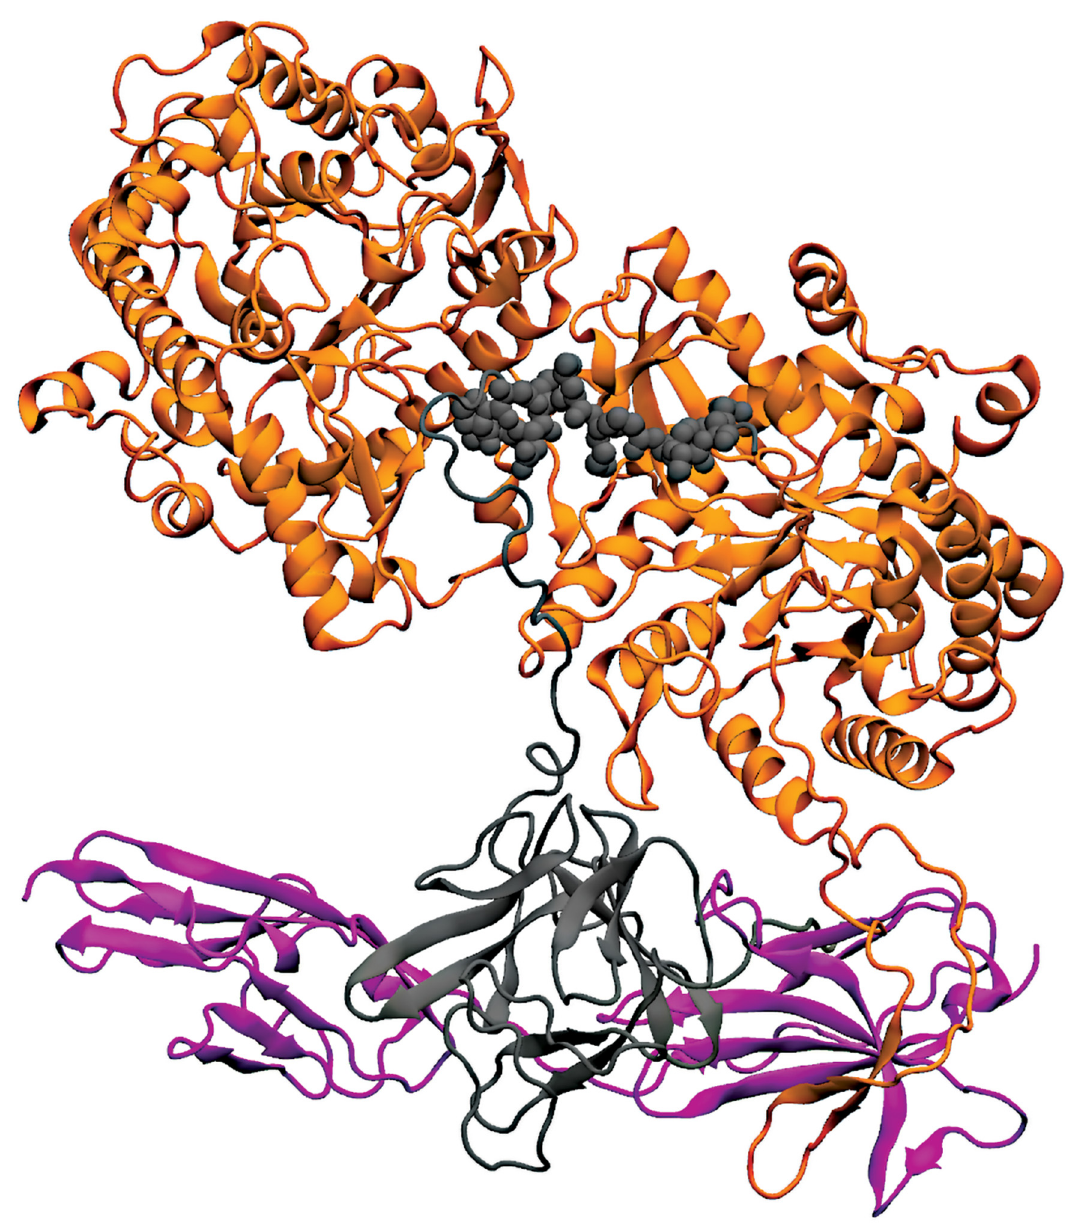
Figure 7. Crystal structure of Protein receptor (FGF23-FGFRc1-KLA) complex. Both KL1 and KL2 domains of KLA backbone are represented in orange, FGF23 protein shown in grey, and receptor FGFR1 is represented in magenta.